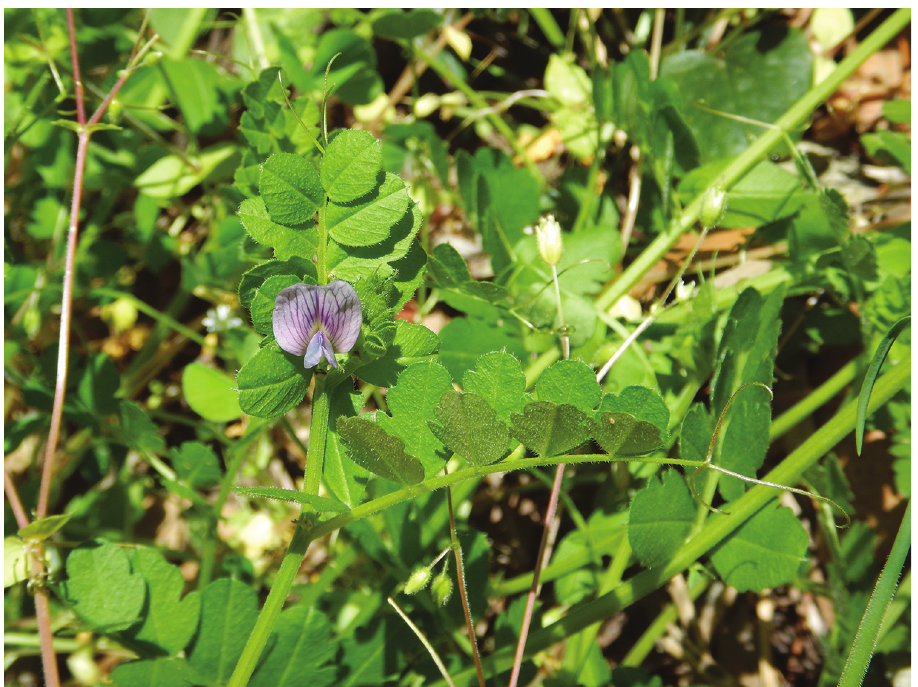
Figure 7. Flowering individual of Vicia incisa at Castelli Romani (Lazio, Italy). Pictures by M.